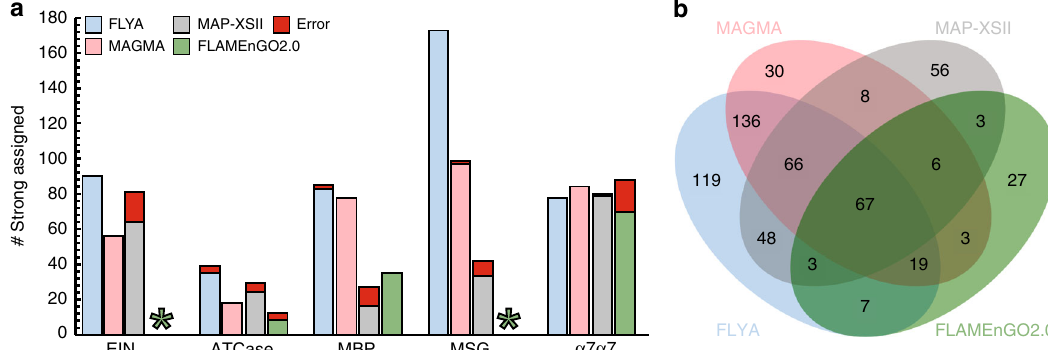
Fig. 5 Comparison of MethylFLYA, MAGMA, MAP-XSII, and FLAMEnGO2.0. a The number of correctly and erroneously strongly (i.e. con fi dently) assigned methyl resonances for each of the cases is shown. Asterisks are given in the places where no con fi dent (100%) assignments could be obtained with the FLAMEnGO2.0 software. b Mutual agreement of the methyl group resonance assignments among the four methods. Numbers of assigned methyls are given in the intersection